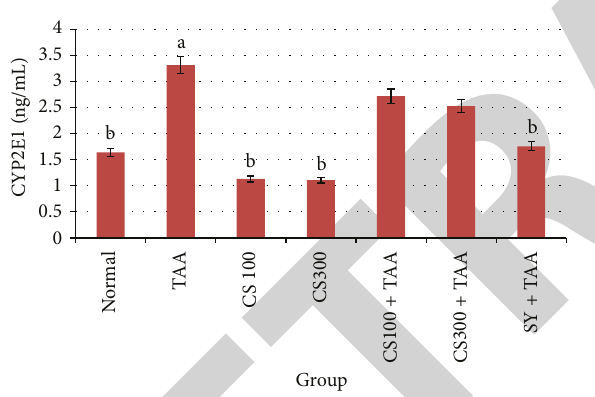
Figure 6: Effect of CS crude extract on hepatic levels of CYP2E1 in rats at the end of 12 weeks. The data were stated as mean ± S.E.M. Means with different superscripts are significantly different. a 𝑃 < 0.05 versus normal control group and b 𝑃 < 0.05 versus TAA control group. SY stands for Silymarin (standard hepatoprotective